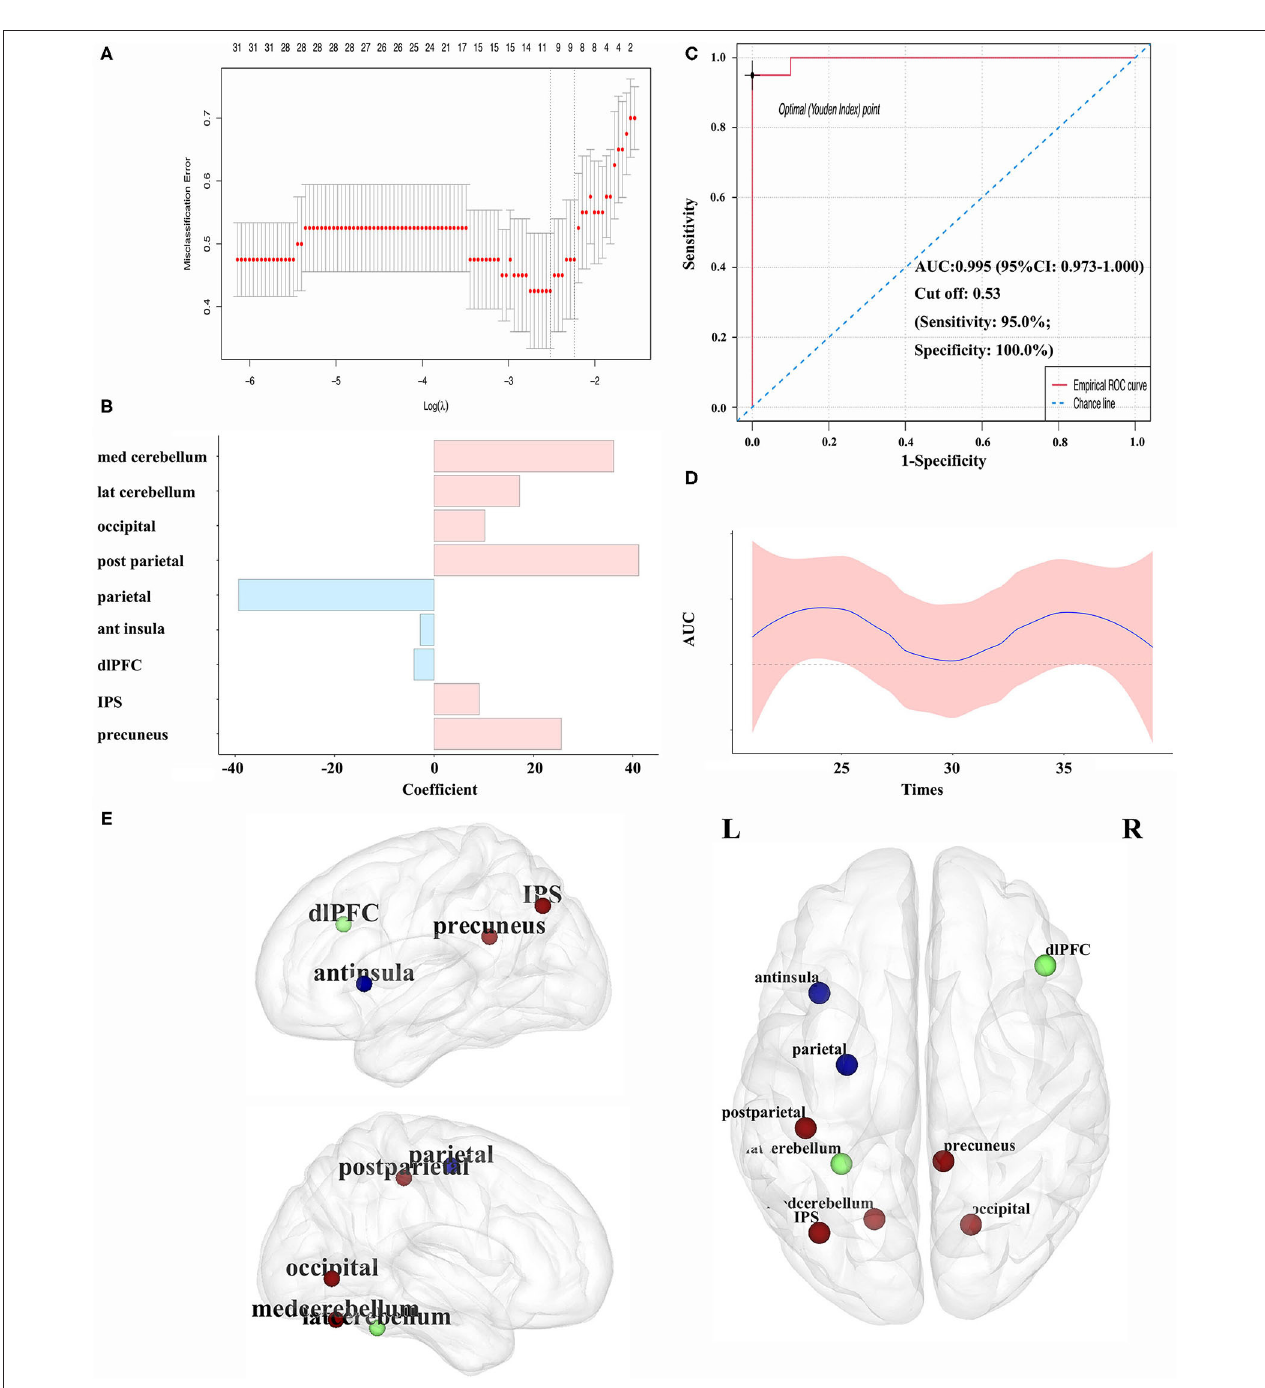
FIGURE 3 | (A) Variables selection by LASSO regression in the classification model; (B) coefficient of each variable in the model; (C) the ROC curves in classifying patients with BSP for the model; (D) internal validation for the model. The testing sets were randomly sampled from the whole cohort by 19 times. The sample size was increased from 21 to 39; (E) abnormal nodal centralities in patients with BSP compared with HCs (the blue node representing the decreased E nod in patients with BSP, the red node representing the increased E nod in patients with BSP, and the green node representing no difference between patients with BSP and HCs). ant, anterior; AUC, area under the curve; BSP, blepharospasm; dlPFC, dorsolateral prefrontal cortex; E nod , nodal efficiency; HC, healthy control; IPS, intraparietal sulcus; LASSO, least absolute shrinkage and selection operator; lat, lateral; med, medial; post, posterior; ROC, receiver operating characteristic; ROI, region of interest.